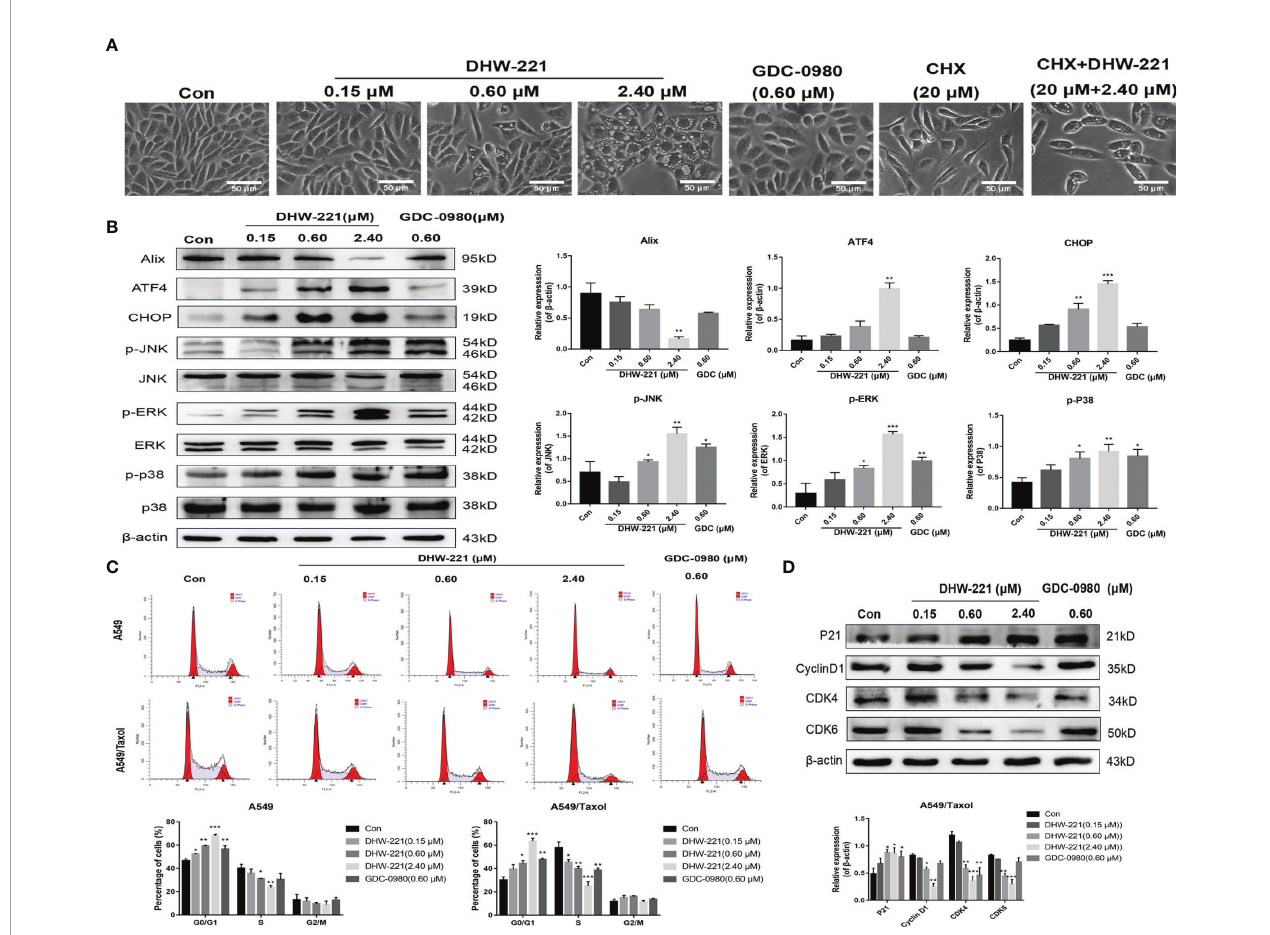
FIGURE 4 | DHW-221 induces paraptosis and cell cycle arrest in A549/Taxol cells. (A) Representative microscope images of DHW-221-incubated A549/Taxol cells. Cells were pretreated with cycloheximide (CHX, 20 m M) followed by DHW-221 (2.40 m M) treatment for 12 h. Scale bar = 50 µm. (B) The expression levels of Alix, ER stress (ATF4 and CHOP) and MAPK signaling pathway related proteins (p-ERK, p-JNK, and p-P38) in A549/Taxol cells were measured by Western blot. The histogram (below) indicated the relative band intensity ratio of each protein for three independent experiments. (h) (C) The cell cycle distribution followed by DHW-221 and GDC- 0980 treatment for 48 h in A549/Taxol cells was illustrated by FACS analysis. (D) The expression levels of cell cycle-associated proteins were measured by Western blot. The relevant quantitative results were shown in the fi gure below. Statistical comparisons were performed with one-way ANOVA followed by Dunnett ’ s post-hoc test for multiple comparisons (n = 3). Data are presented as mean ± SD. *p < 0.05, **p < 0.01, ***p < 0.001 versus